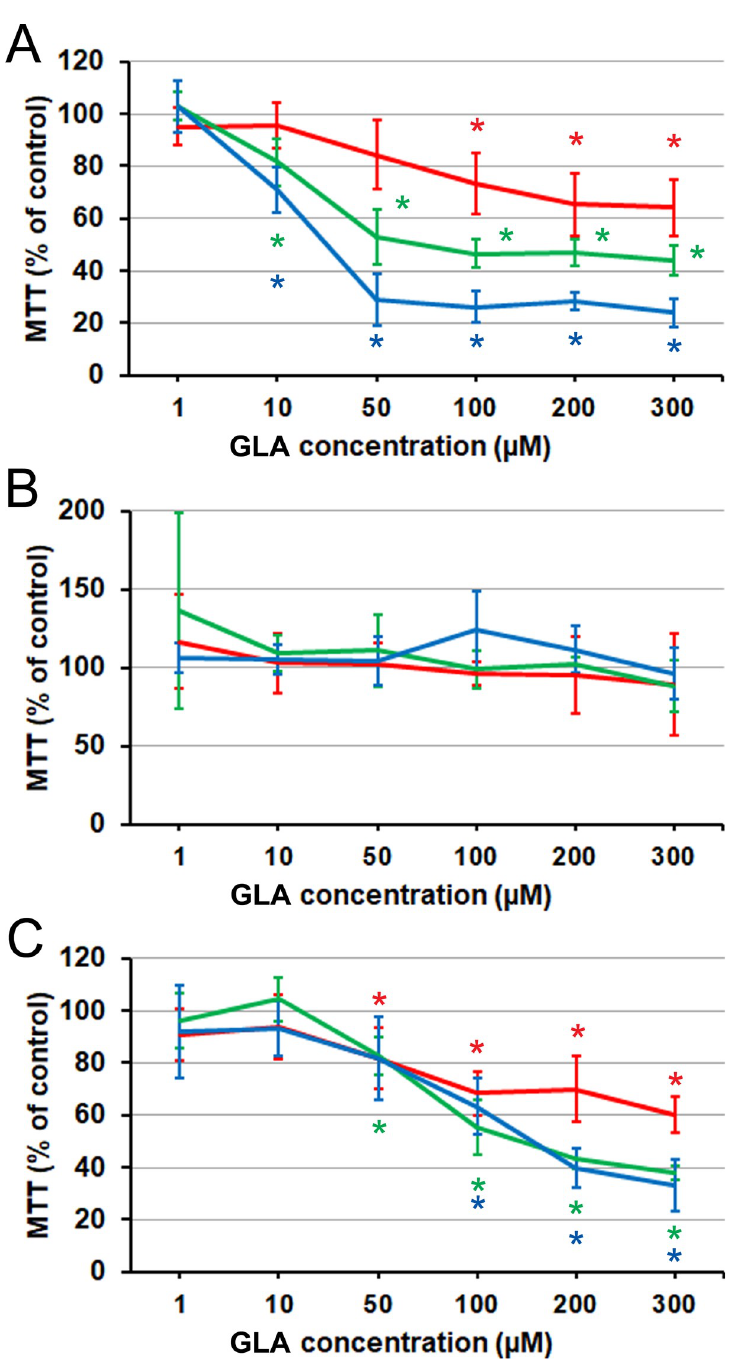
Fig 4. Effect of GLA on prostate cancer cells proliferation and viability as measured by MTT assay. (A) PC3 cells. (B) LNCaP cells. (C) C4-2 cells. Red line: 24 h. Green line: 48 h. Blue line: 72 h. Error bars: standard deviation. Asterisk: difference from the control is significant on the significance level 0.05, corrected for multiple comparisons. Each data point is the average of n = 9 cell cultures.